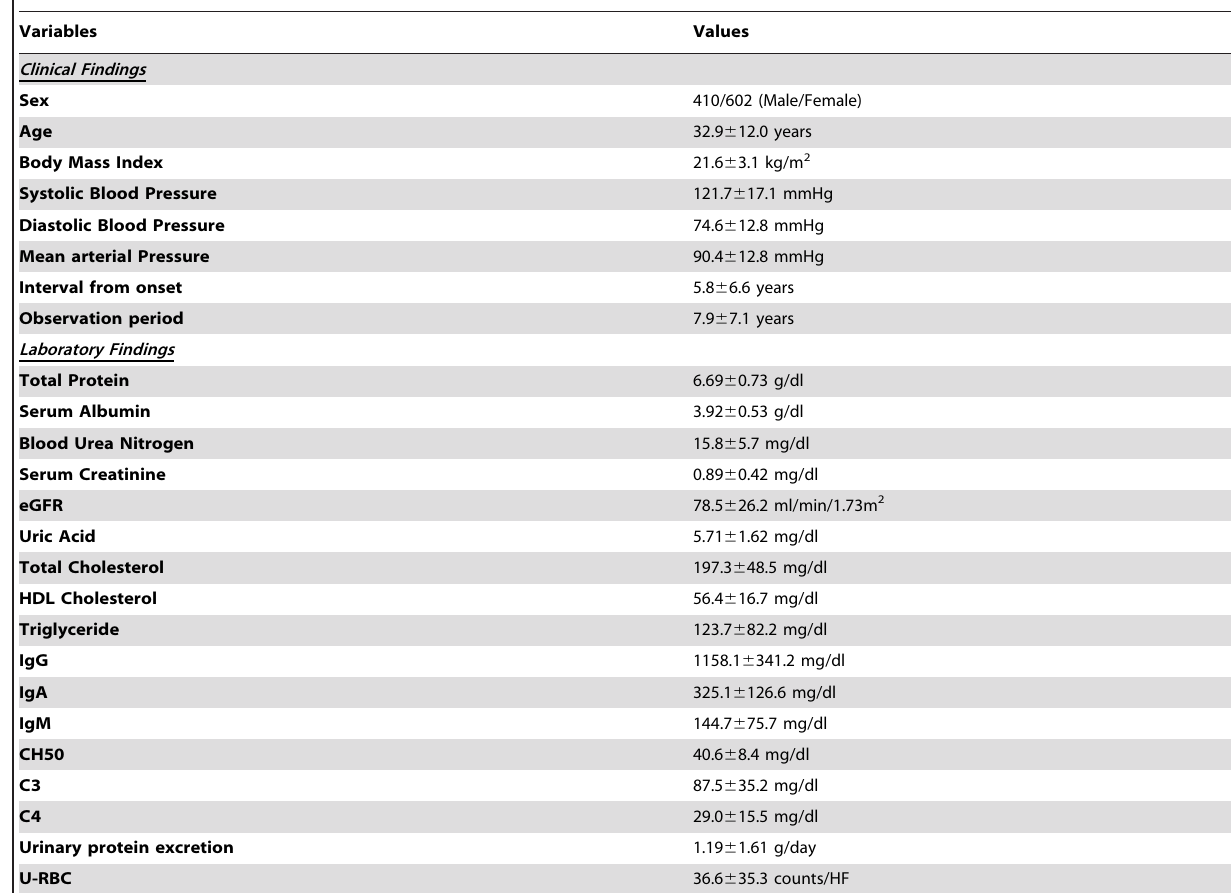
Table 1. Clinical and laboratory findings at renal biopsy.